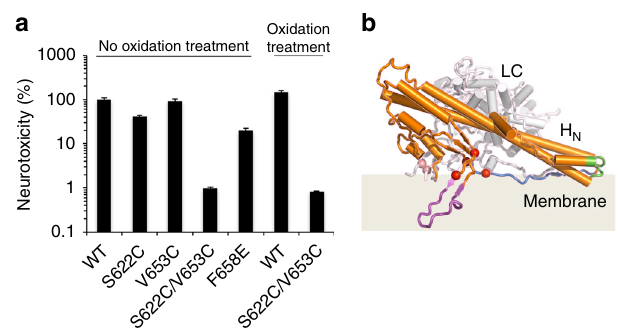
Fig. 5 The BoNT-switch modulates neurotoxicity of BoNT/A1. a Neurotoxicity of BoNT/A1 variants was analyzed using the MPN assay. The paralytic half-times were determined and converted to the corresponding concentrations of wild-type BoNT/A1 using a concentration – response curve. The resulting toxicities were expressed relative to wild-type BoNT/A1 ( n = 3 – 6, ± S.D.). b Proposed model for insertion of BoNT/A1 into lipid bilayer. The β 2/ β 3 loop and the two putative membrane-interacting segments, F667 – I685 and R827 – R836, are colored in magenta, blue, and green, respectively. The inter-chain disul fi de bond and four conserved carboxylates (D625, D629, E666, E670) are drawn as salmon and red spheres,